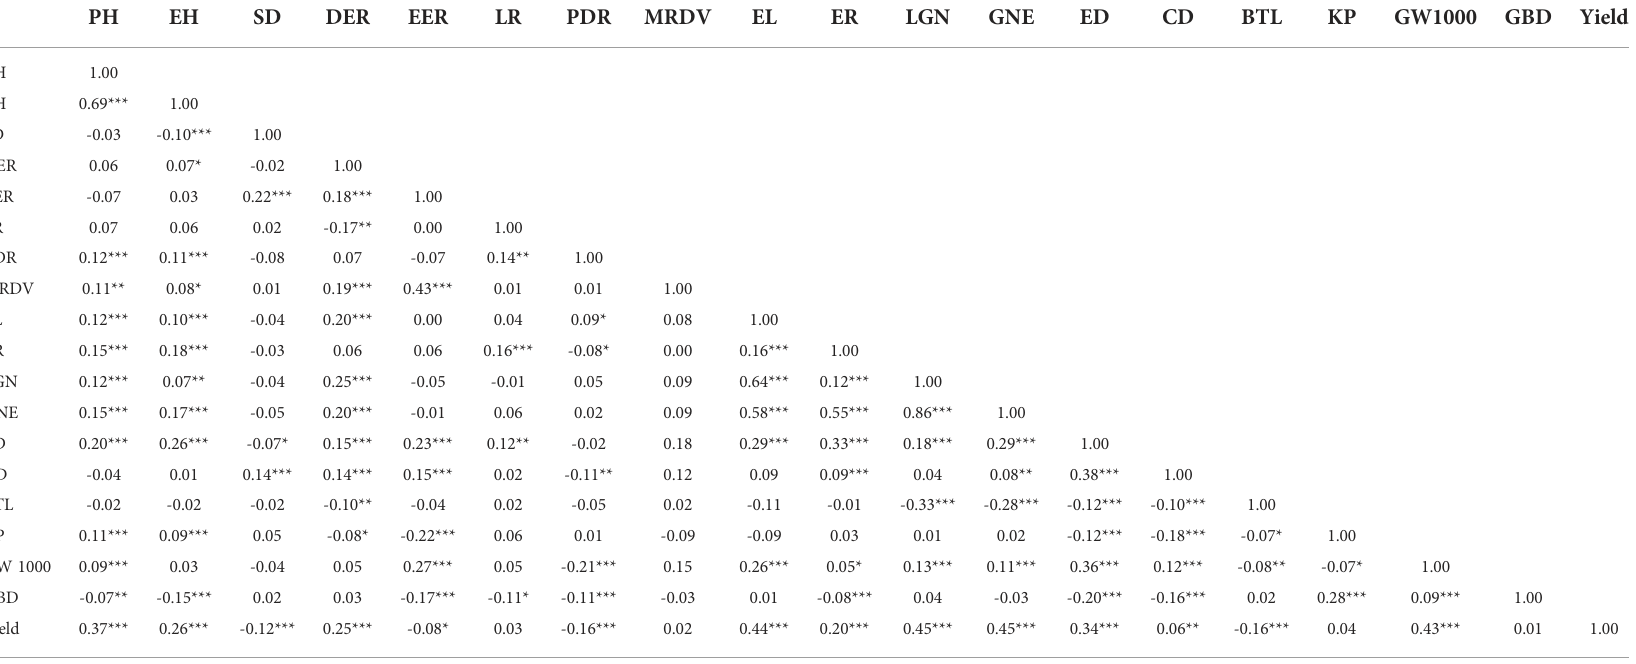
TABLE 2 Matrix of correlation coeffcients between plant agronomic traits and yield of maize based on linear relationships. PH EH SD DER EER LR PDR ER GNE GBD